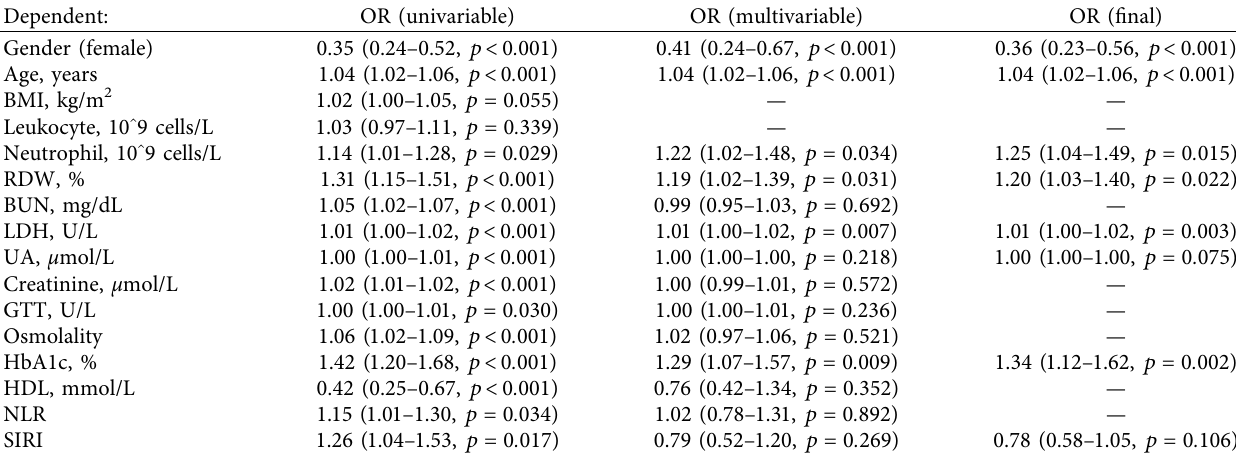
Table 3: Stepwise backward logistic regression analysis for the risk of CVD in COPD.